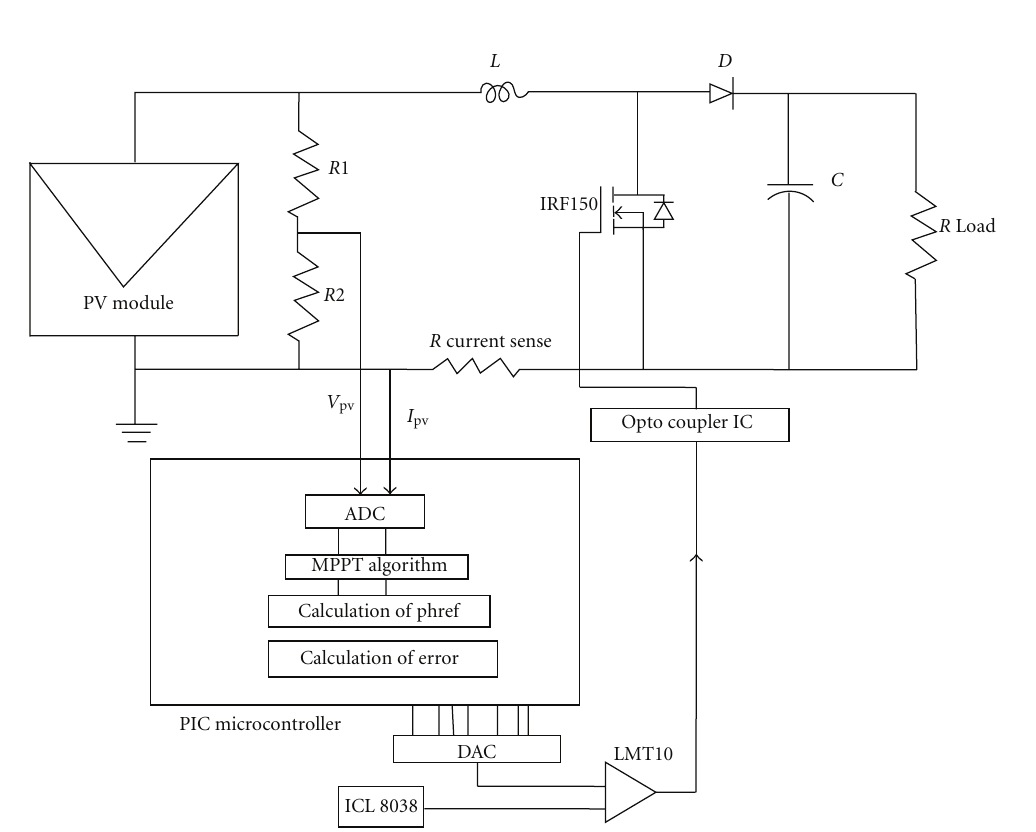
Figure 22: MPPT control circuit.